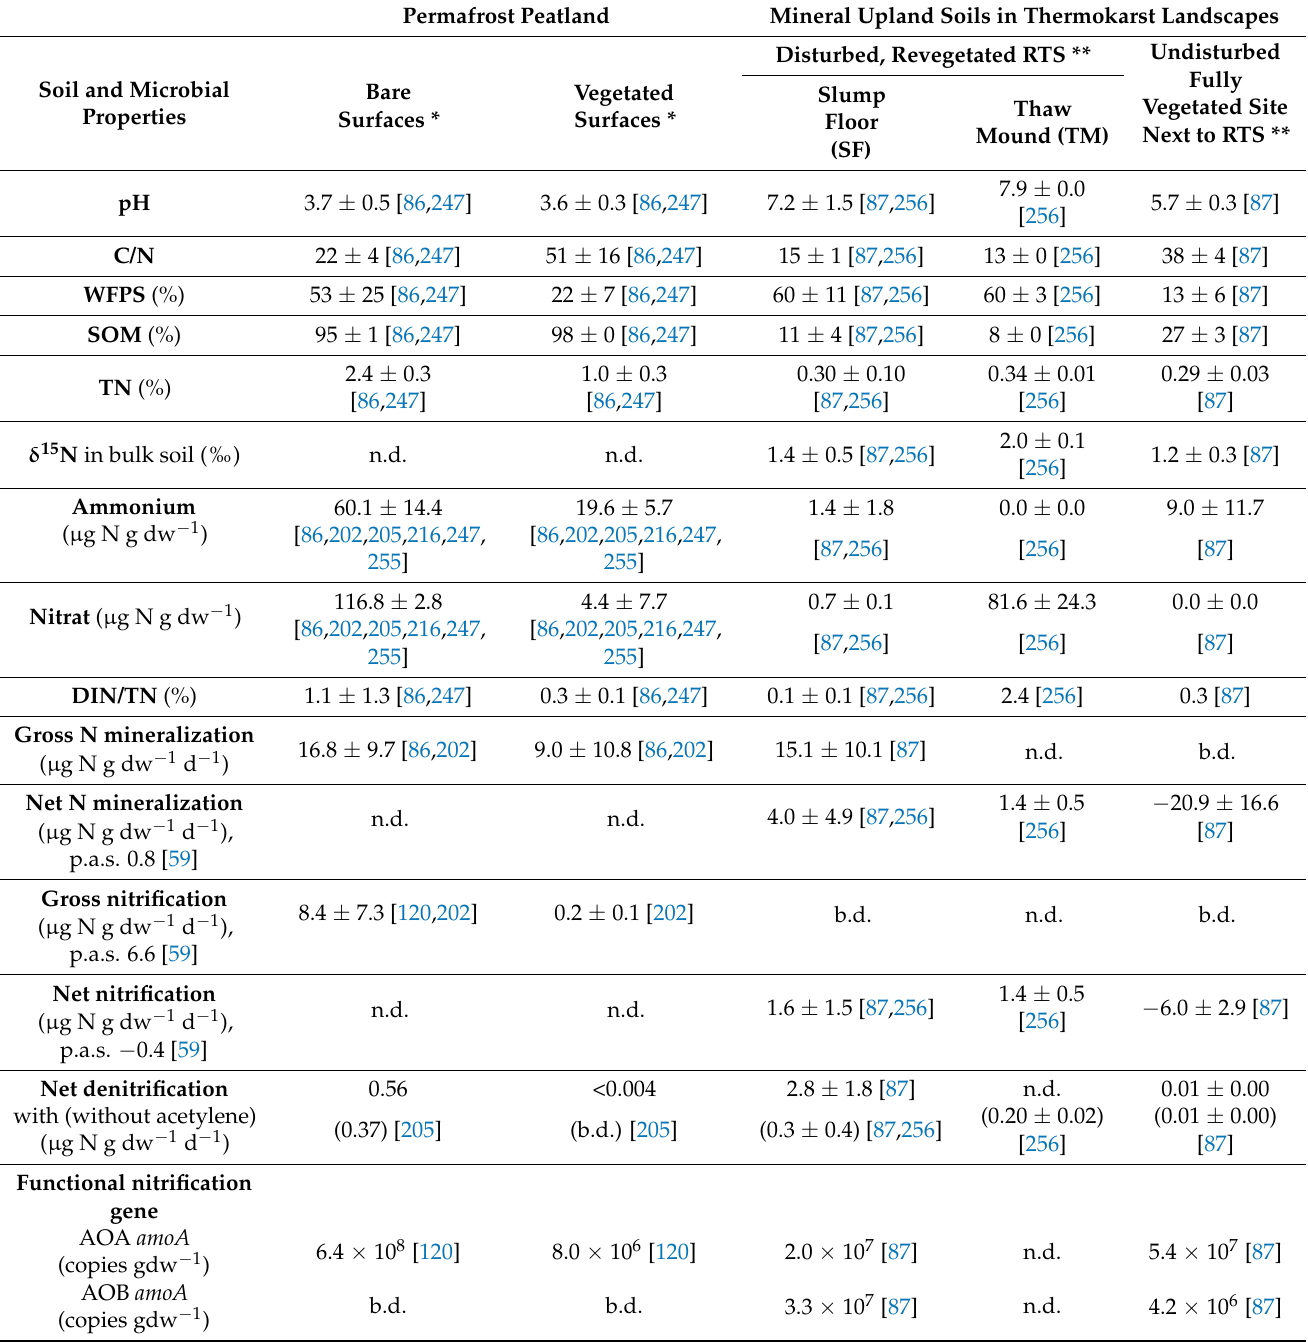
Table 1. Soil properties, gross and net N turnover rates, abundance of functional N genes, and in situ N 2 O fluxes at two types of N availability hotspots: exemplified by a best described site of bare surfaces on permafrost peatland and thermokarst disturbed and revegetated retrogressive thaw slump (RTS), and undisturbed sites associated with the hotspots: vegetated surfaces on permafrost peatland and intact, fully vegetated soil adjacent to thaw slump, respectively. For RTS sites, a distinction was made between two subsites: slump floor (SF) and thaw mound